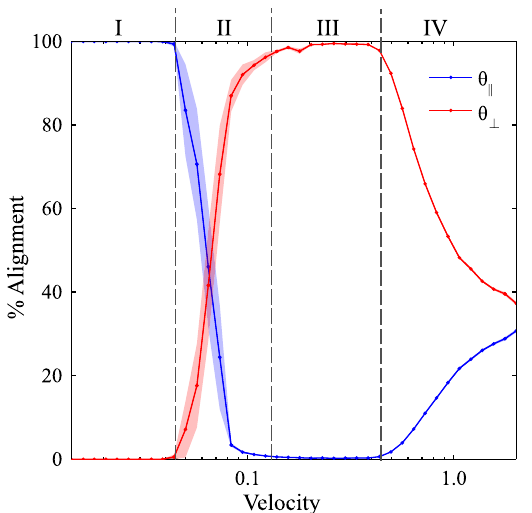
Figure 7. The percent alignment of lamellae to within ± 30 degrees of the directions parallel and perpendicular to the direction of zone velocity. The zone width is w zone = 80 ˜ l . Four distinct regions emerge as a function of zone velocity: (I) parallel orientation, (II) transition from parallel to perpendicular orientation, (III) perpendicular orientation, and (IV) transition to unaligned